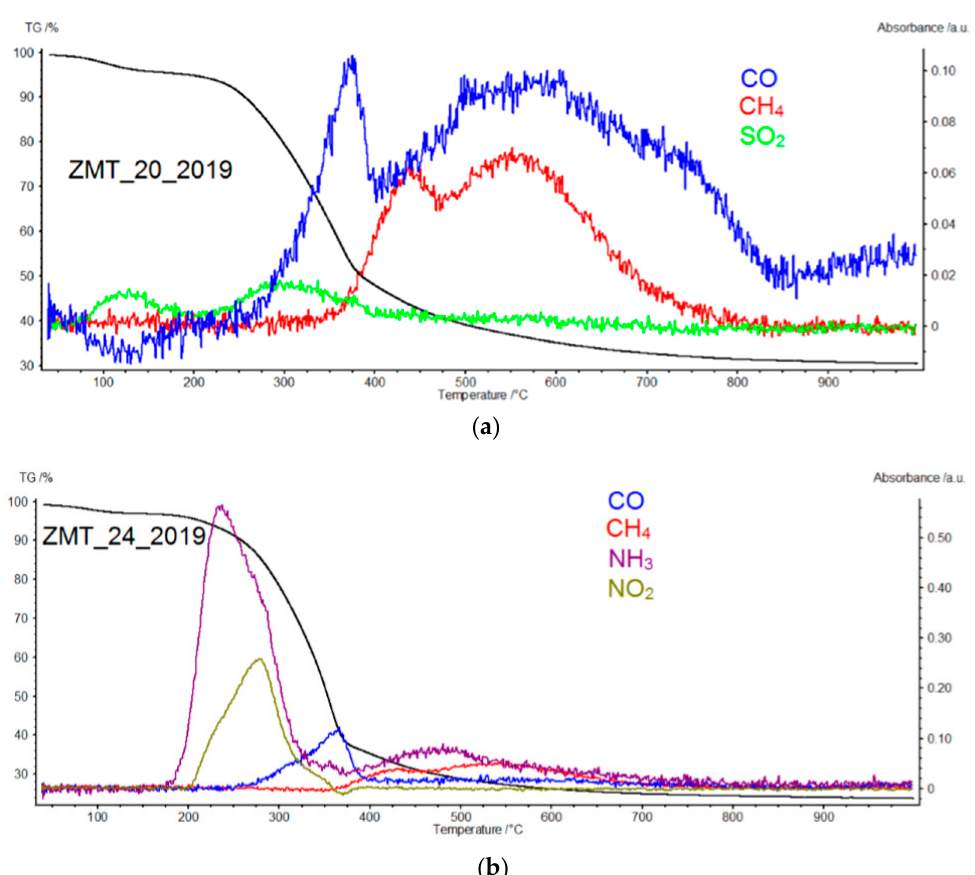
Figure 7. TG curve and curves of emissions of carbon monoxide, methane, nitrogen dioxide, and ammonia for the samples ( a ) ZMT/20/2019 and ( b ) ZMT/24/2019 (own research).